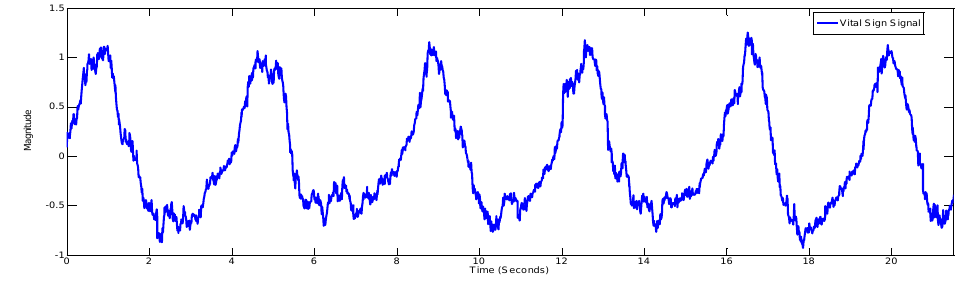
Figure 4. The column with highest variance/energy.